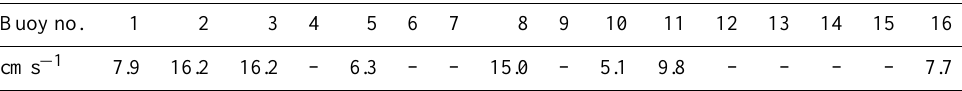
Fig. 10. Composite time development of ice-drift vorticity, divergence and magnitude of deformation for 10 different triangles within the D07 buoy array during cyclone (left) and anticyclone (right) passages. The time is relative to the vorticity maximum (minimum). The buoys and the number of cases used for each triangle composite are listed in the upper panels. Note the different ordinate scales for cyclones and anticyclones. Table 4. Mean maximum–minimum difference of ice-drift oscillations in cms − 1 in the D07 buoy array during the one-week period 13 and 19 August after the cyclone passage on 13